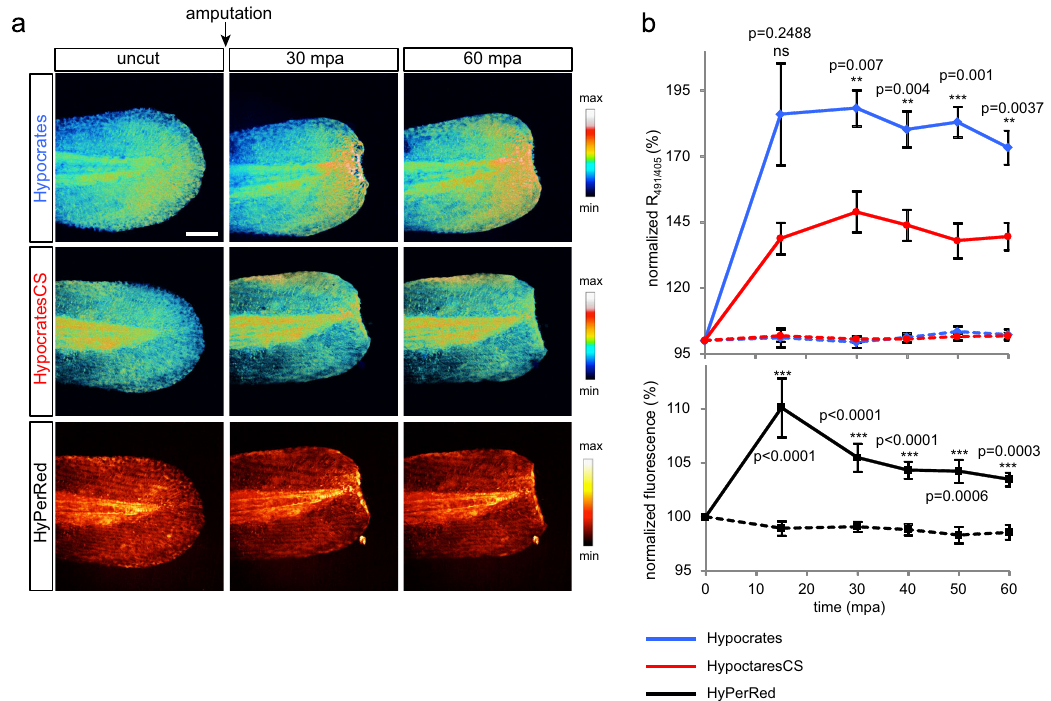
Fig. 6 Hypohalous acids and H 2 O 2 dynamics during zebra fi sh larvae wounding. a Hypocrates and HyPerRed imaging. Zebra fi sh embryos were co- injected with Hypocrates or HypocratesCS and HyPerRed mRNAs at the 1-cell stage, and a tail fi n amputation assay was performed on 48 h post- fertilization larvae. Images were taken before amputation, and time lapse imaging was performed up to 60 min post-amputation (mpa). The lookup tables indicate changes in the oxidation states of the sensors. Scale bar = 100 µ m. b Hypocrates ratio and HyPerRed fl uorescence were quanti fi ed at the amputation plane and normalized to the mean fl uorescence on the uncut tail for each larva. Ratio quanti fi cation on larvae tail fi n expressing Hypocrates (blue lines) or HypocratesCS (red lines) is shown. Two-way ANOVA test with a Tukey ’ s multiple comparisons posttest was used to determine if the observed difference was statistically signi fi cant. Non-amputated embryos (dashed lines) expressing Hypocrates or HypocratesCS were also imaged as a control (values ± SEM; N = 4 experiments, n ≥ 3 embryos/timepoint; ns no signi fi cant, ** P < 0.01, *** P < 0,001, versus HypocratesCS cut larvae, P -values are shown). For control embryos (dotted lines), fl uorescence has been normalized for each embryo to the fi rst image of the time lapse ( t = 0). HyPerRed fl uorescence quanti fi cation on larvae tail fi n expressing HyPerRed (black lines) is shown (values ± SEM, N = 3 experiments, n ≥ 7 embryos/timepoint; *** P < 0.001, versus uncut larvae (dashed line), P -values are shown). Source data are provided as a Source Data fi